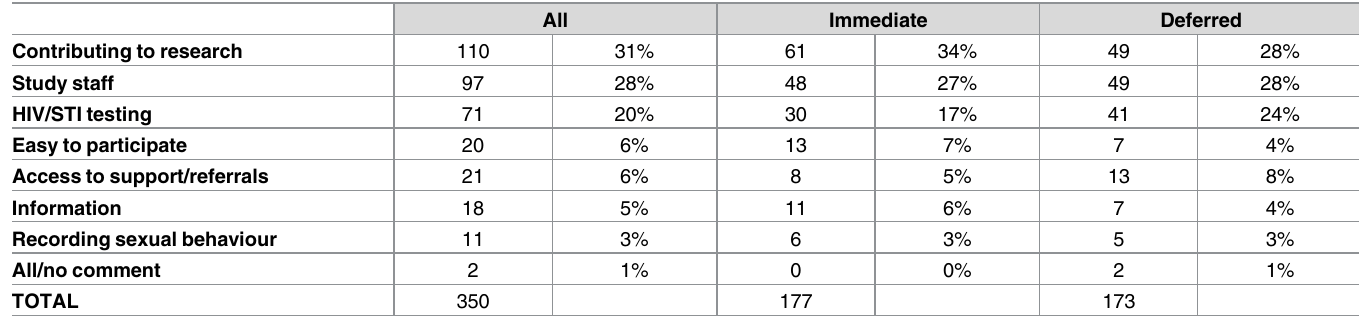
Table 2. What participants most liked about the